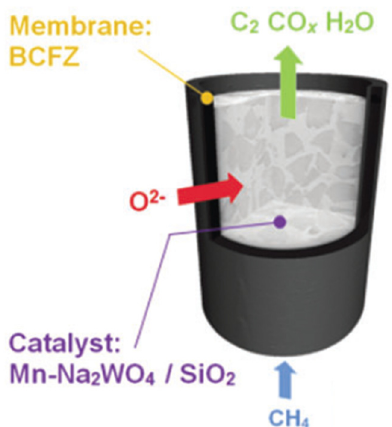
Figure 11. Schematic representation of the lab-scale Oxidative Coupling of Methane (OCM) packed bed membrane reactor constructed in the project using the developed catalyst and Mixed Ion-Electron Conducting (MIEC) membranes.